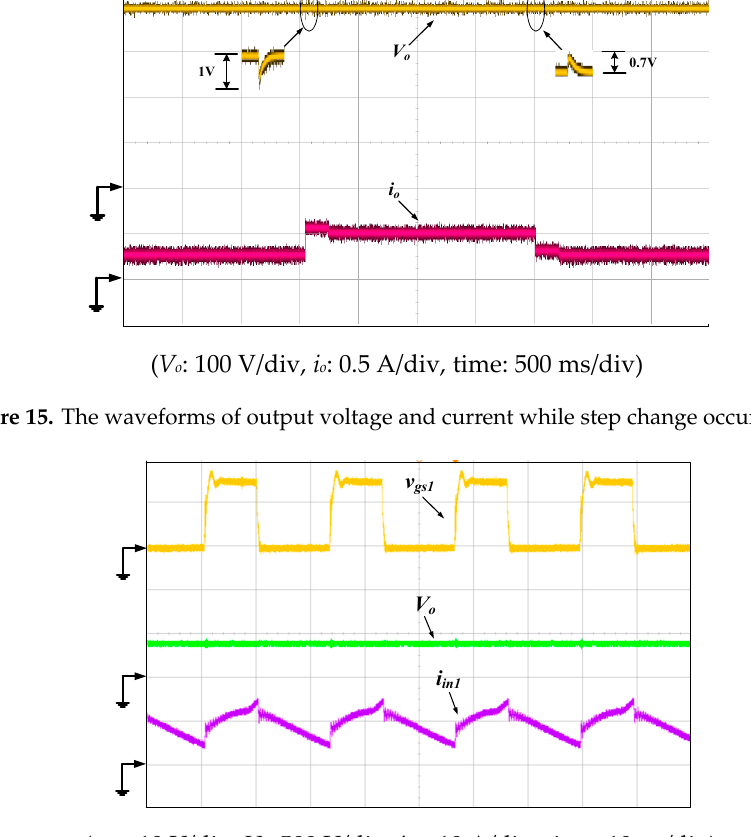
Figure 16. The measured waveforms of the control signal, output voltage, and input current while input 2 encounters power failure.